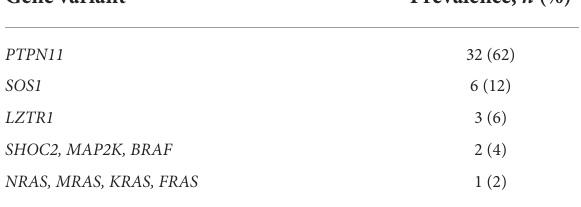
TABLE 1 The prevalence of gene pathogenic variants: (In total, 52 patients underwent genetic diagnosis). Gene